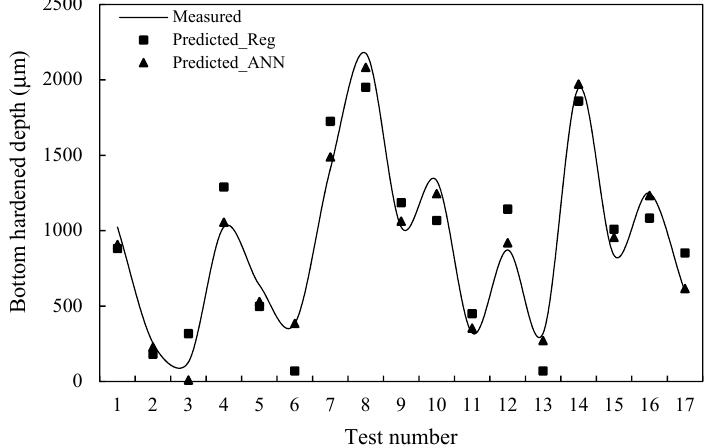
Figure 16. Curve fitting of measured and predicted tooth top hardened depth.